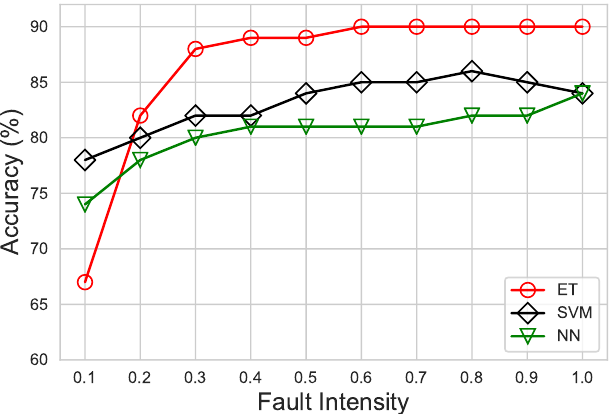
Figure 11. Diagnostic accuracy comparison of ET versus SVM and NN under the proposed CAFD scheme.